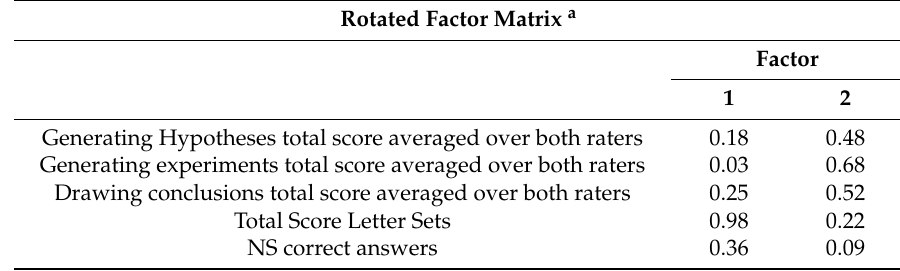
Table 14. Rotated maximum likelihood common factor analyses in Study 2 without new scales with analytical ability tests.